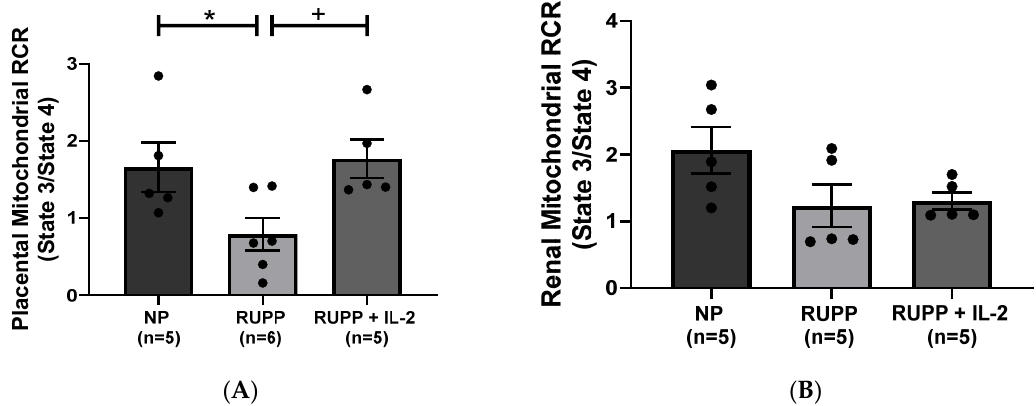
Figure 5. ( A ). Placental RCR (state 3/state 4) was reduced in RUPP ( n = 6) compared to both NP rats ( n = 5) and RUPP + LD IL-2 rats ( n = 6). ( B ). Renal RCR (state3/state 4) was reduced in RUPP rats ( n = 5) compared to NP rats ( n = 5).There was no significant difference in RCR demonstrated in RUPP + LD IL-2 rats ( n = 5) compared to RUPP rats. Results were reported as means ± SEM and considered statistically significant when p < 0.05. (* p < 0.05 vs. NP control; + p < 0.05 vs. RUPP). Mt ROS significantly increased in endothelial cells, HUVECS, exposed to media containing sera from RUPP ( n = 4) (6.38 ± 1.81% gated, p < 0.05) compared to NP controls ( n = 5) (1.86 ± 0.6% gated) (Figure 6), but was normalized in RUPP + IL-2 rats ( n = 7) (2.69 ± 0.53% gated, p < 0.05) compared to RUPP, Figure